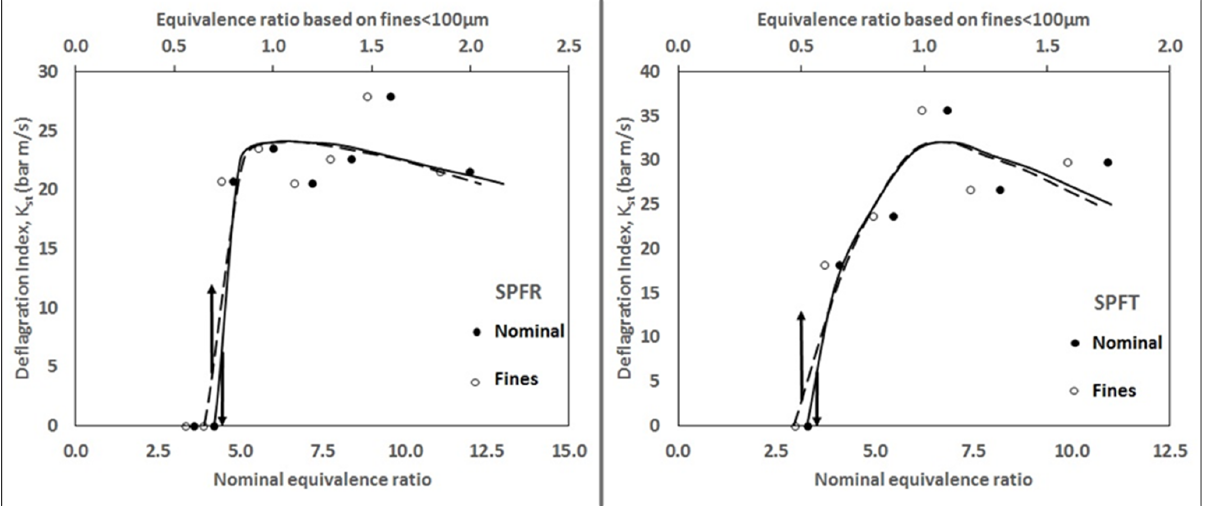
Figure 4. Deflagration Index (K st ) vs. Equivalence ratio (Ø) for raw SPF (SPFR) and torrefied SPF (SPFT) wood mixture.